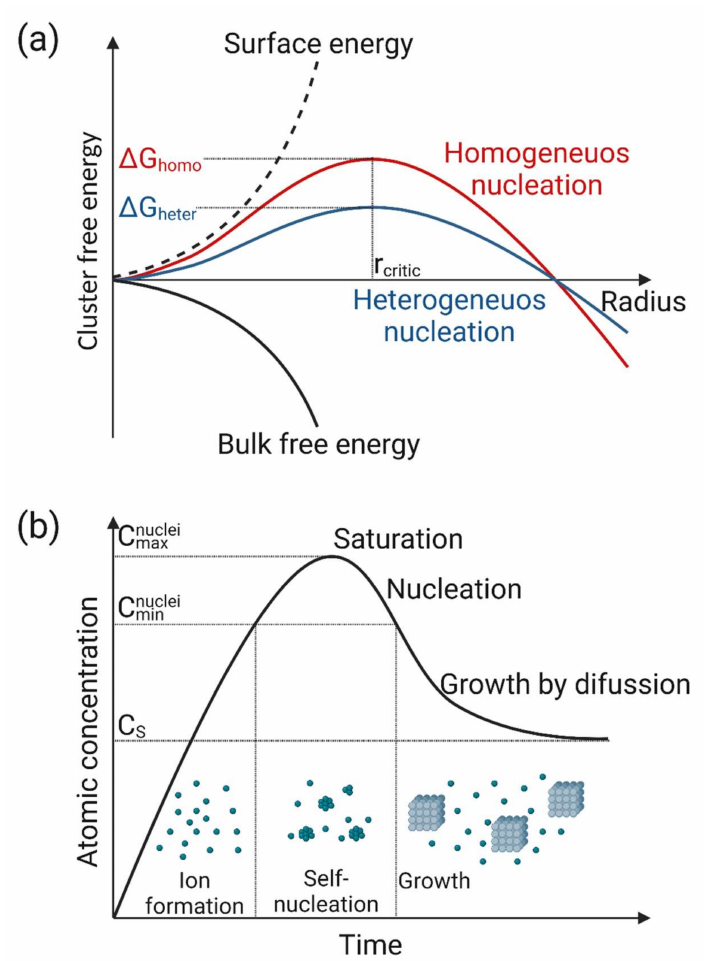
Figure 3. Schematic representation of the nucleation steps ( a ) In the classical nucleation theory, cluster-free energy ( ∆ G) is influenced by the cluster radius (r). The maximum ∆ G is reached at the critical cluster size r c when the first stable particles are formed. ( b ) Nucleation mechanism proposed by La Mer and Dinegar in which nanoparticle formation is shown as a function of time. The image was created with